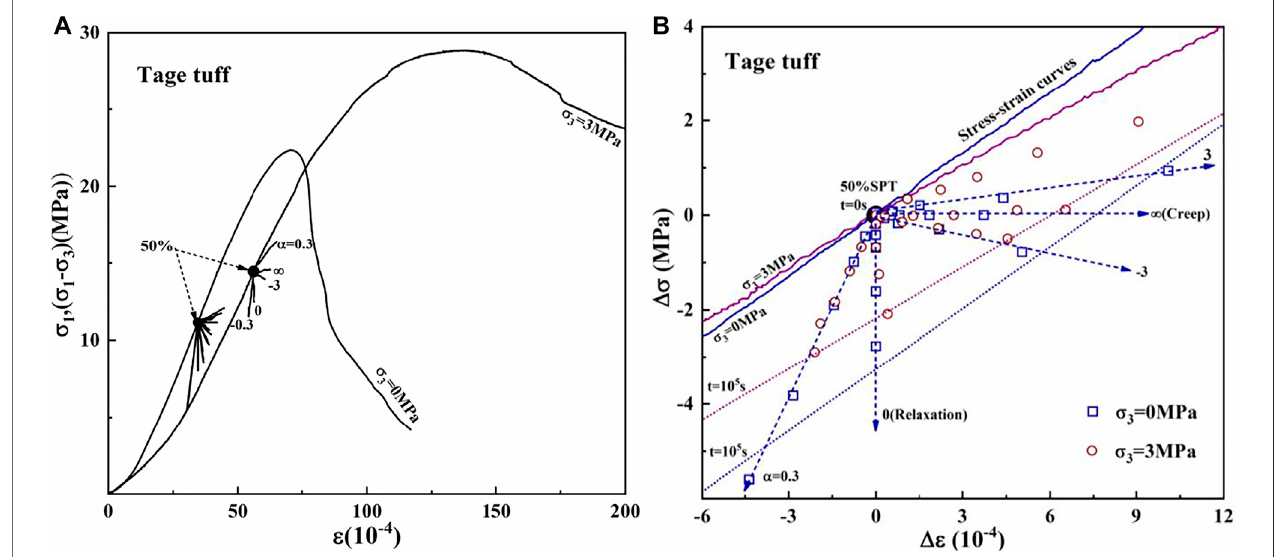
FIGURE 4| Generalized relaxation test results for Tage tuff (A) The location ofstress and strain at 50% stress level under uniaxial and triaxial compression. (B) The larger result of left diagram, SPT of stress and strain at t (cid:2) 0 s set to zero.